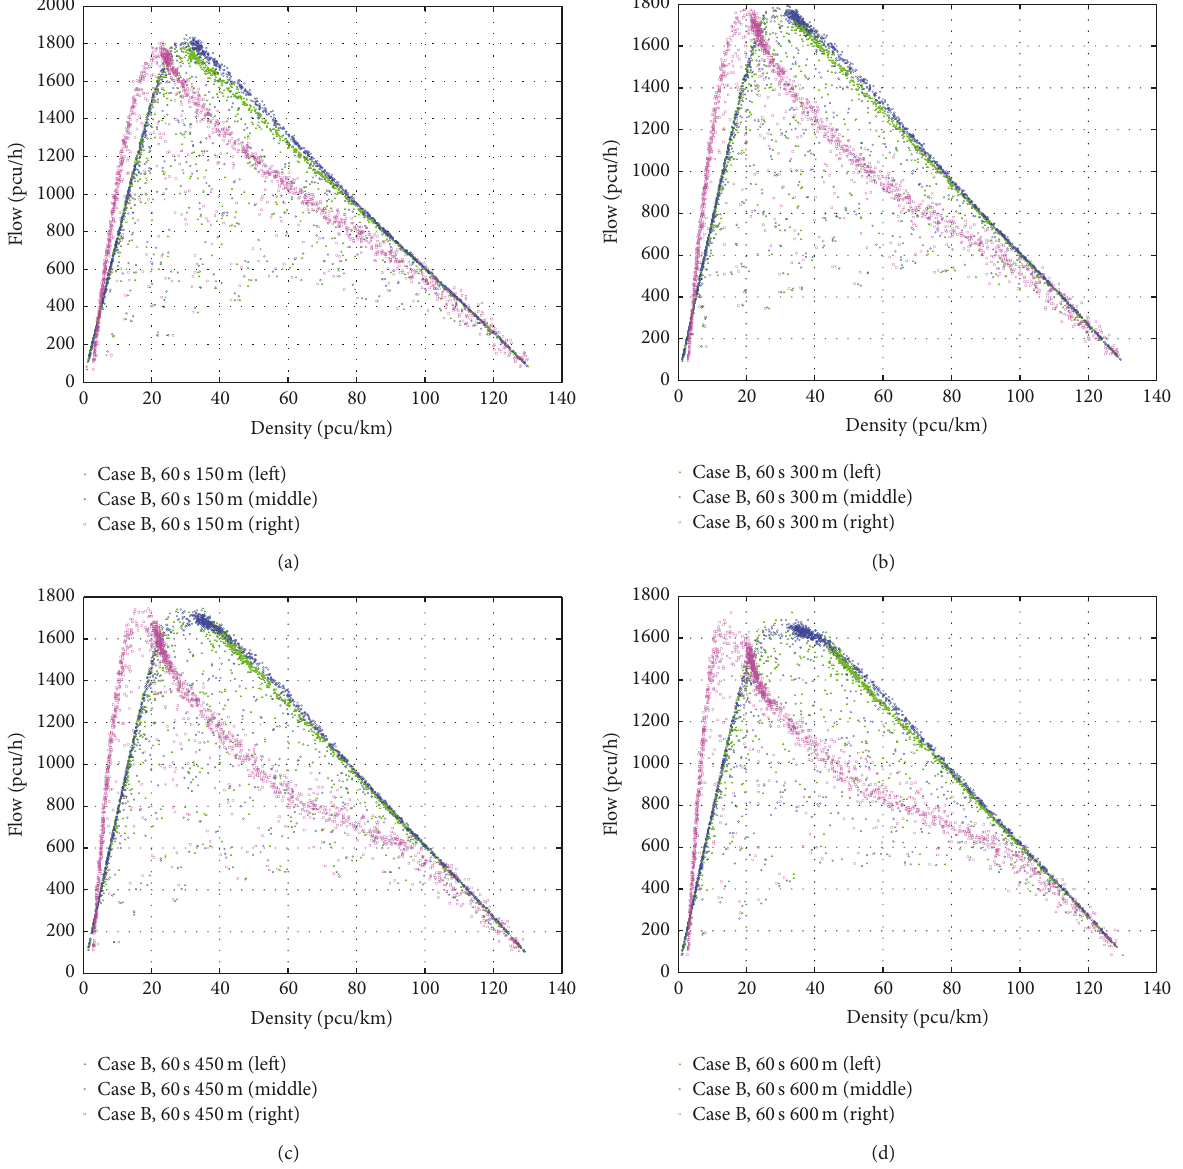
Figure 13: Density-flow relationships with different clear distance in Case B. (a) 𝑙